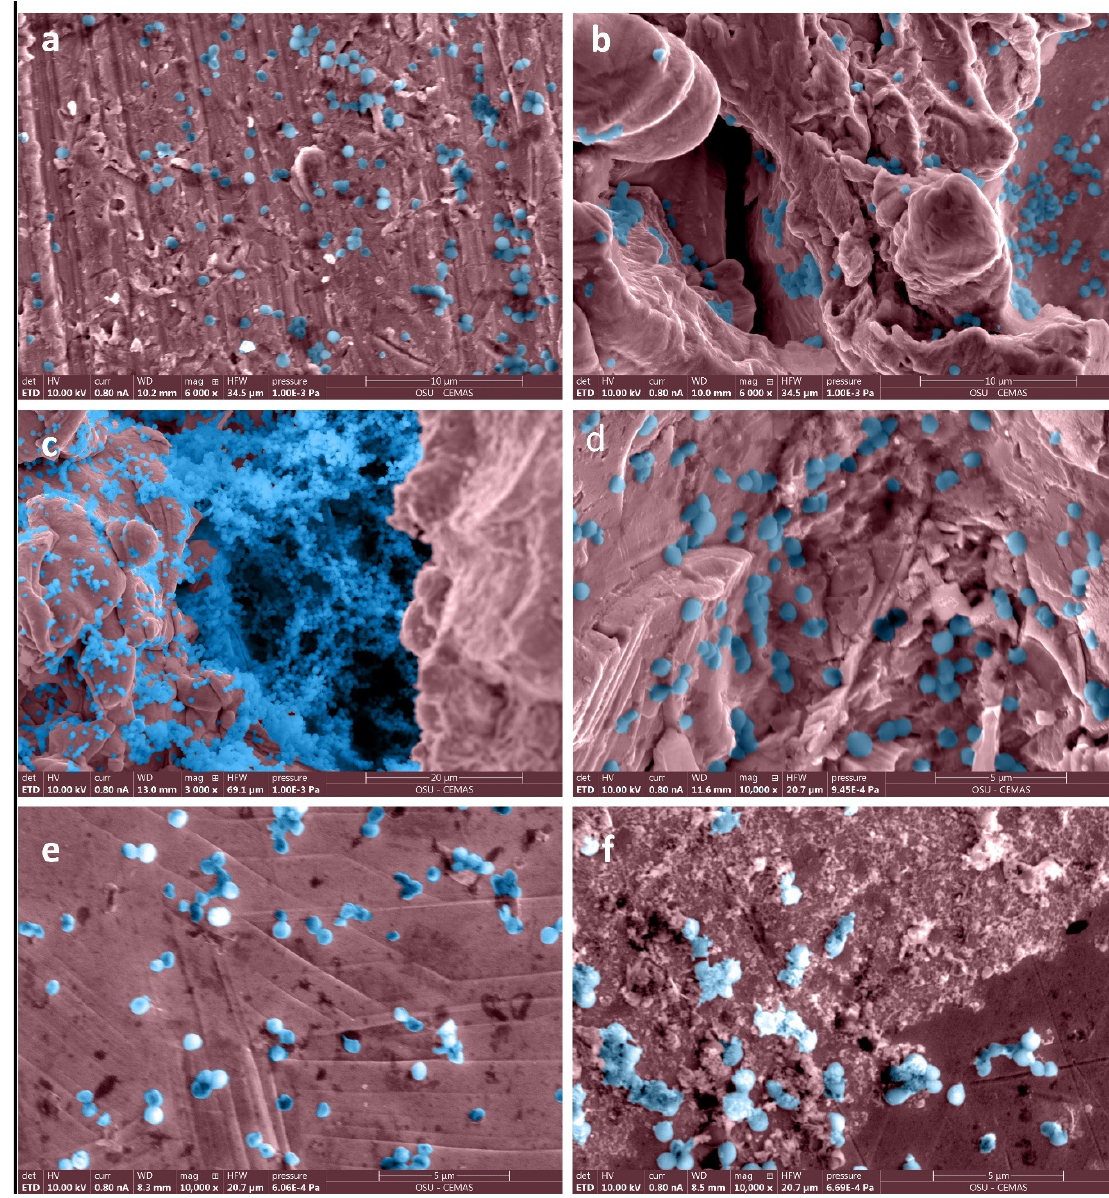
Figure 2. False-colored SEM images of bacteria adhered to surfaces with different roughness on femoral hip stem and fixation plate. Roughness values (Ra ± σ in µm) on surfaces of a femoral stem were ( a ) 4.14 ± 0.32, ( b ) 71.94 ± 4.85, ( c ) 78.44 ± 2.77, ( d ) 17 ± 0.42, and of fixation plate ( e , f ) were 4.76 ± 0.51. Original grayscale SEM images are included as Figure S1 in Supplementary Figures.